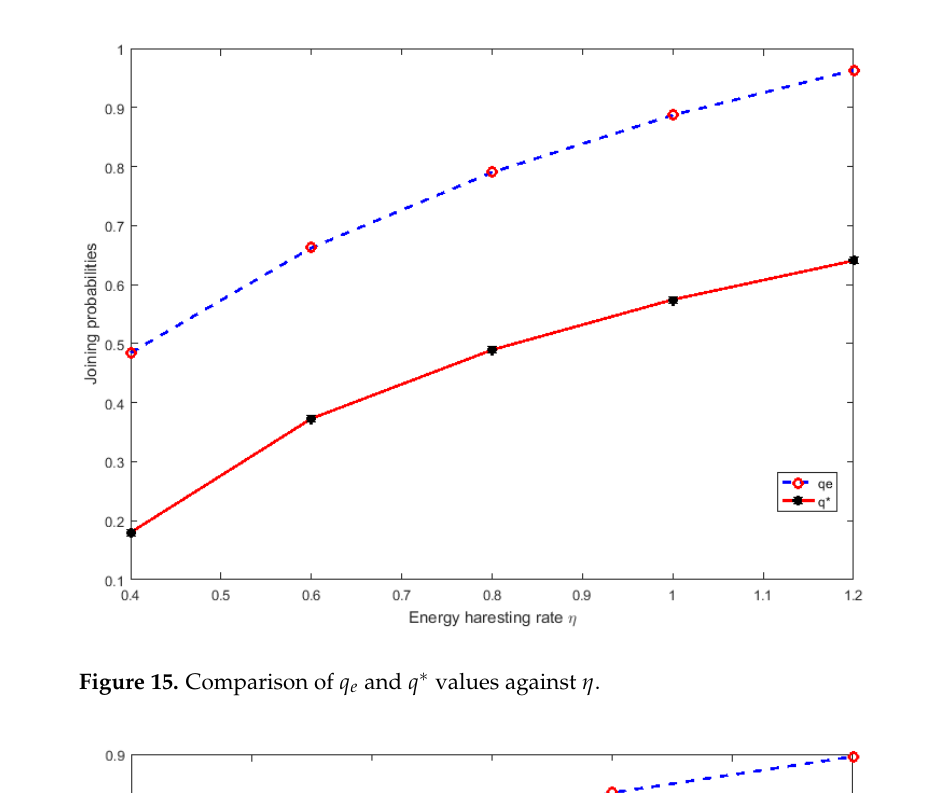
Figure 15. Comparison of q e and q ∗ values against η .